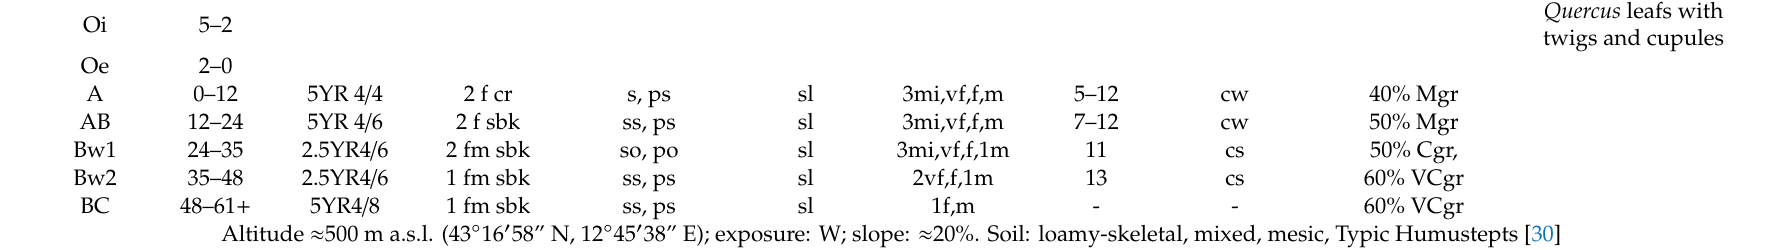
Other Observations cm